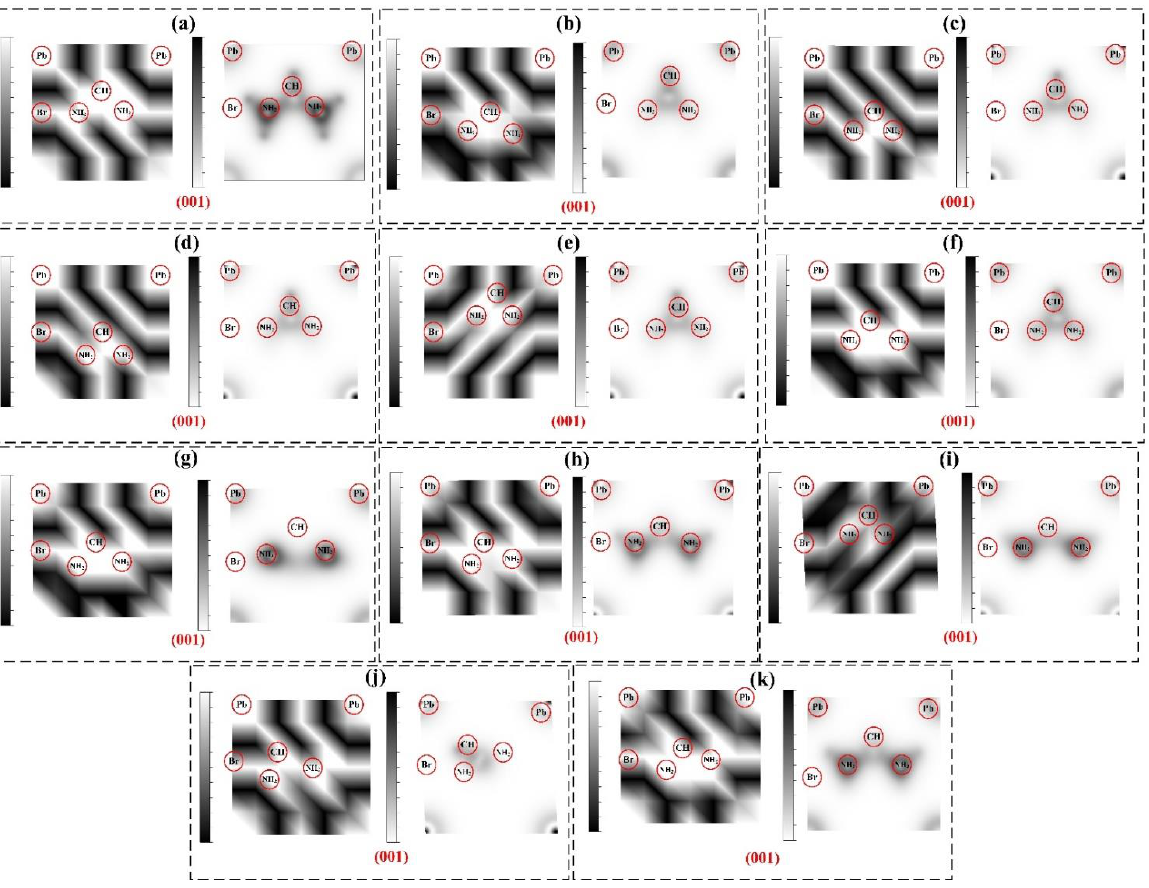
Figure 3. Calculated band structure of FAPbBr 3 perovskite with SOC for rotational modes of ( a ) 0°-X, ( b ) 15°-Y, ( c ) 30°-Y ( d ) 45°-Y, ( e ) 60°-Y, ( f ) 75°-Y, ( g ) 15°-X, ( h ) 30°-X, ( i ) 45°-X, ( j ) 60°-X and ( k ) 75°-X. ( l ) Variations of bandgap and lattice parameter in term of rotational orientation. SOC is shown with red dashed line in CBM.